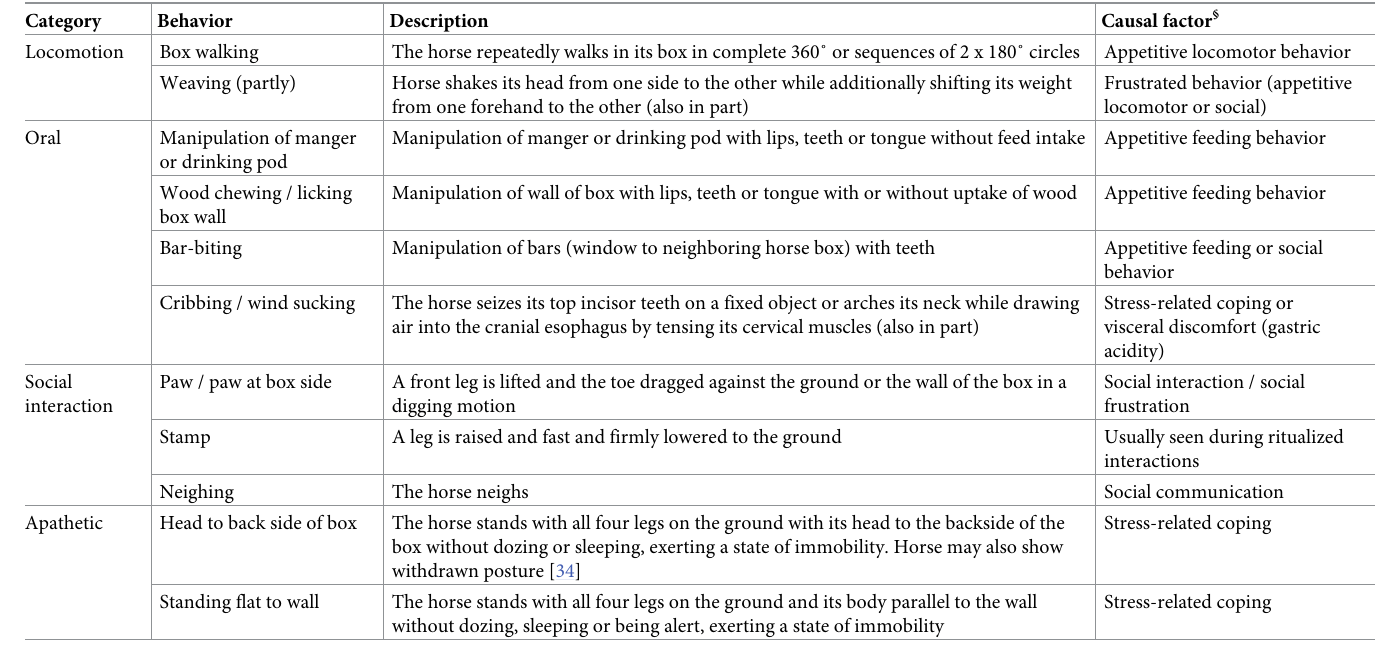
Table 1. Ethogram for stereotypy-related behaviors and behavior patterns associated with frustration or stress response in stabled